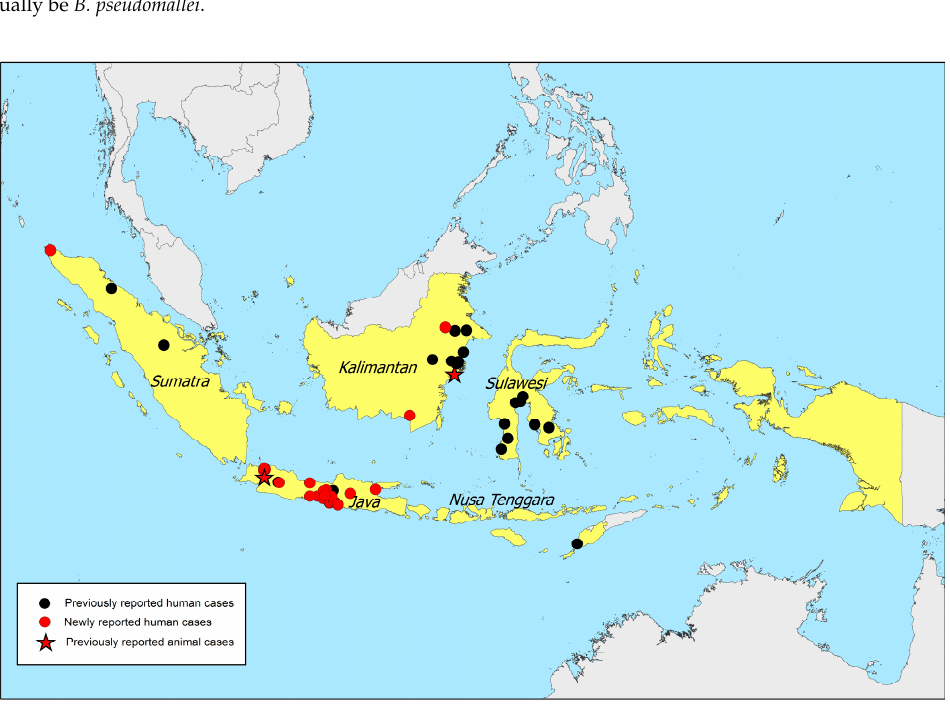
Table 4. Specimens, diagnostic method and reported but unverified antibiotic susceptibility test results in 42 culture-confirmed melioidosis cases with available clinical data from 2012 to 2017.